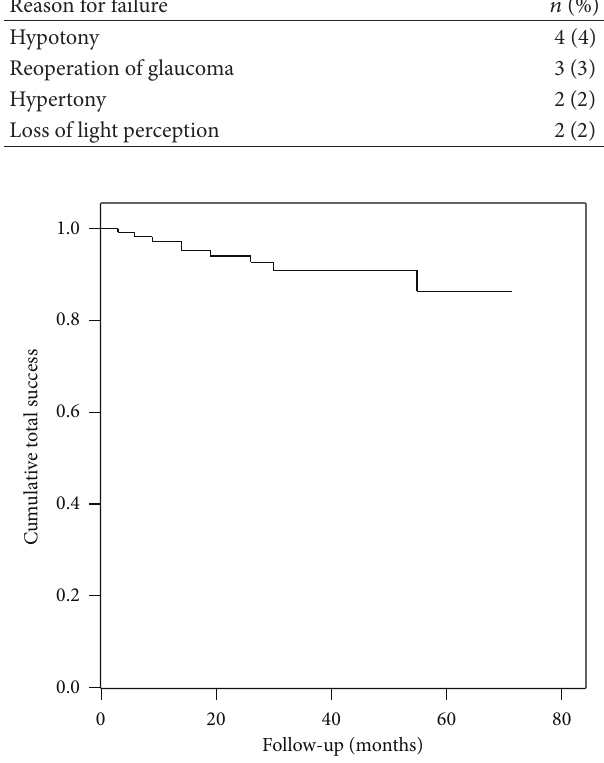
Figure 1: Life-table curve of cumulative total success rates for 106 eyes treated with Molteno3 implantation as primary glaucoma surgery.